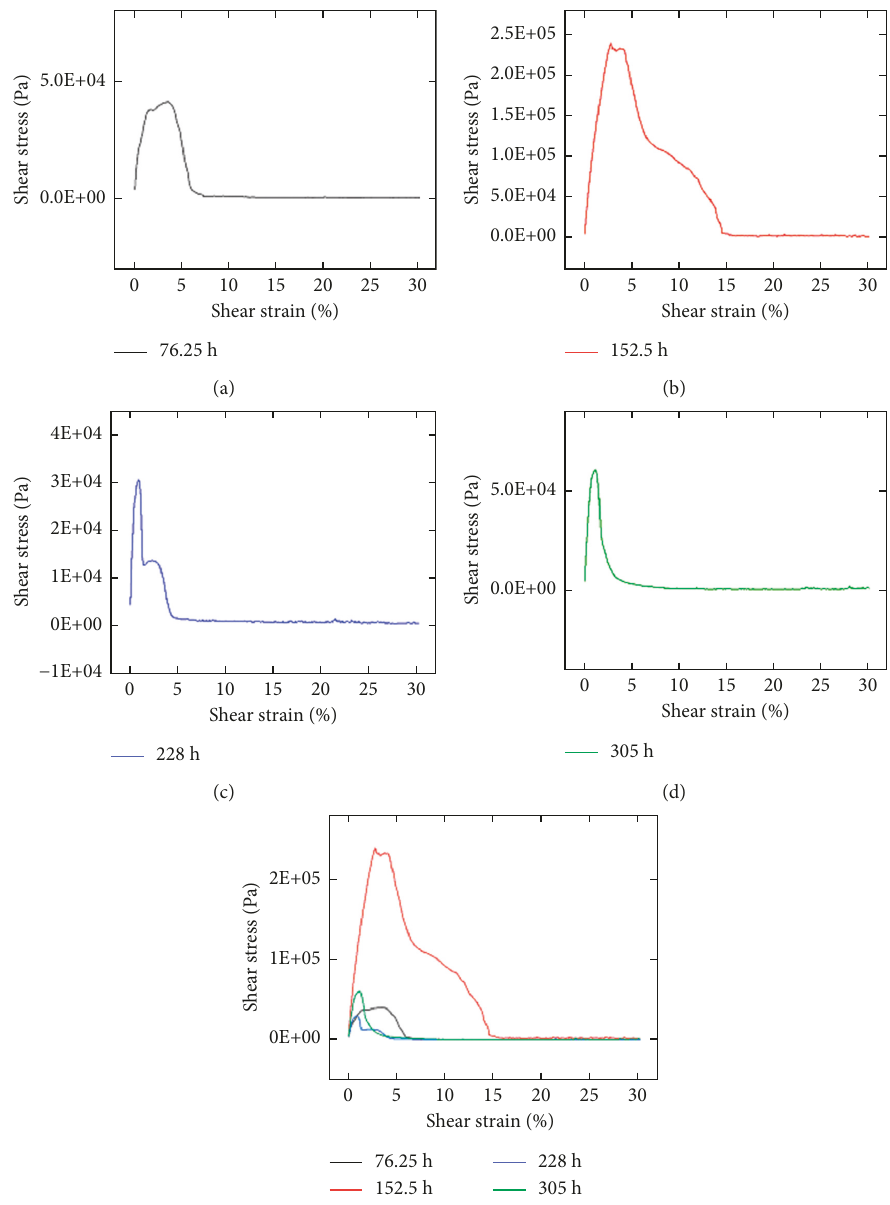
Figure 10: LAS results of 70# asphalt subjected to different UV aging